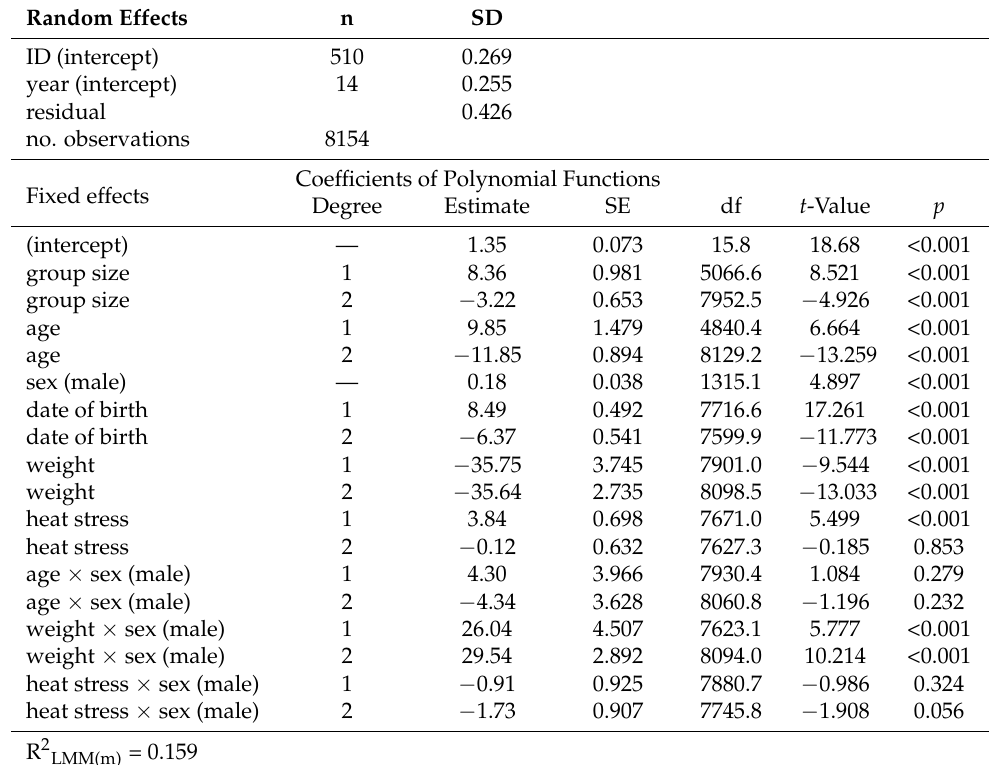
Table 4. Coefficients and statistics of a polynomial mixed model on the response of pelt biting to group size, age (in years), sex, date of birth (day of year), body weight (weight, kg), heat stress (THIWS, see Methods), animal identity (ID), and year. Female is the sex of reference. Other acronyms as in Table